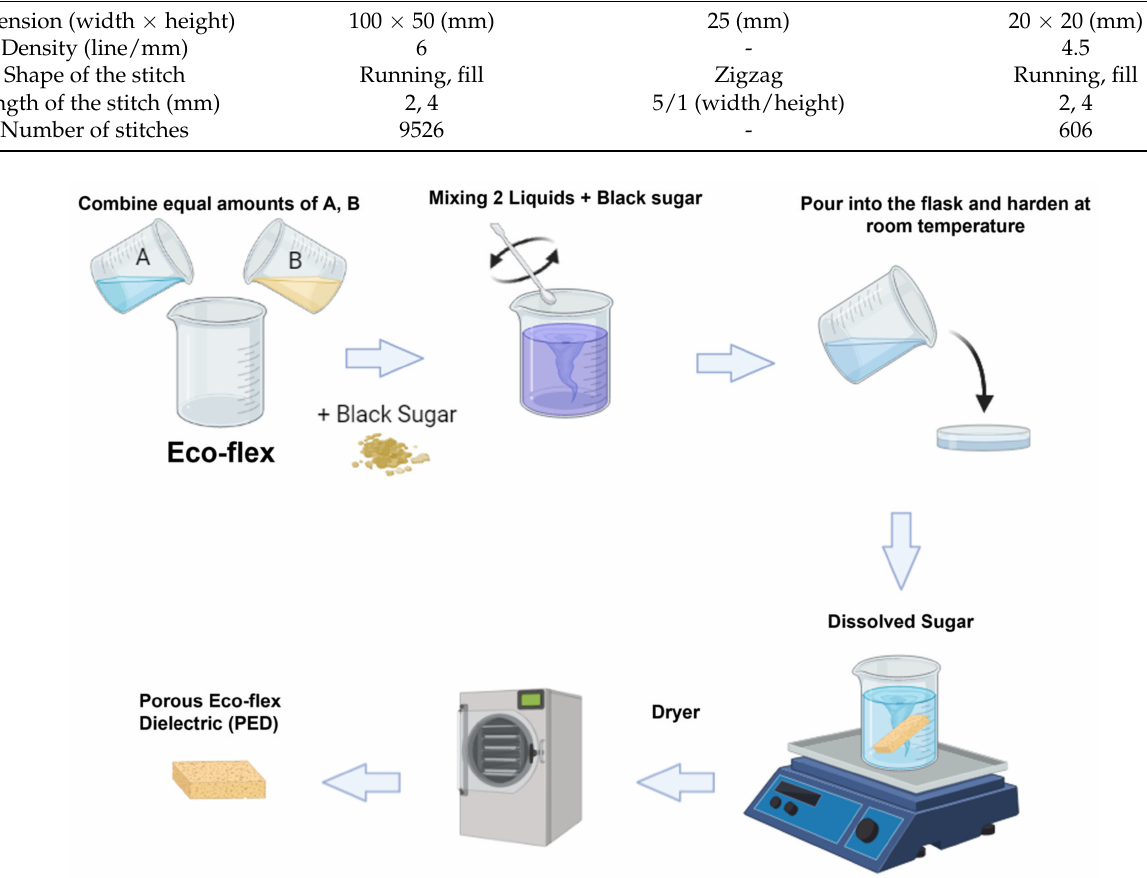
Figure 8. The fabrication process of